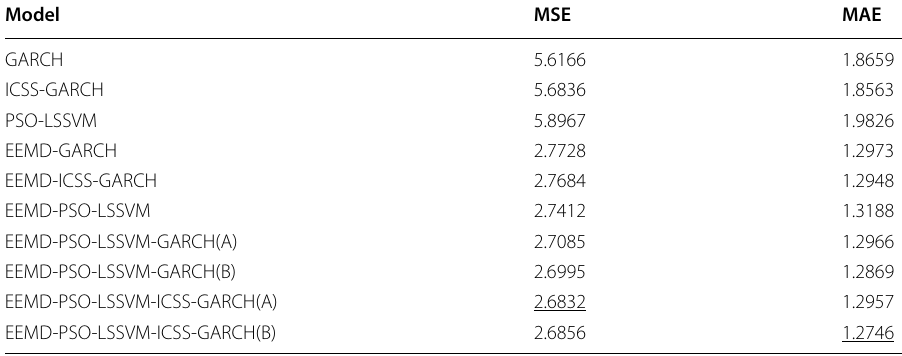
The numbers in the table refer to the values of the two loss functions. The underlined numbers indicate that the corresponding models have the lowest forecasting losses